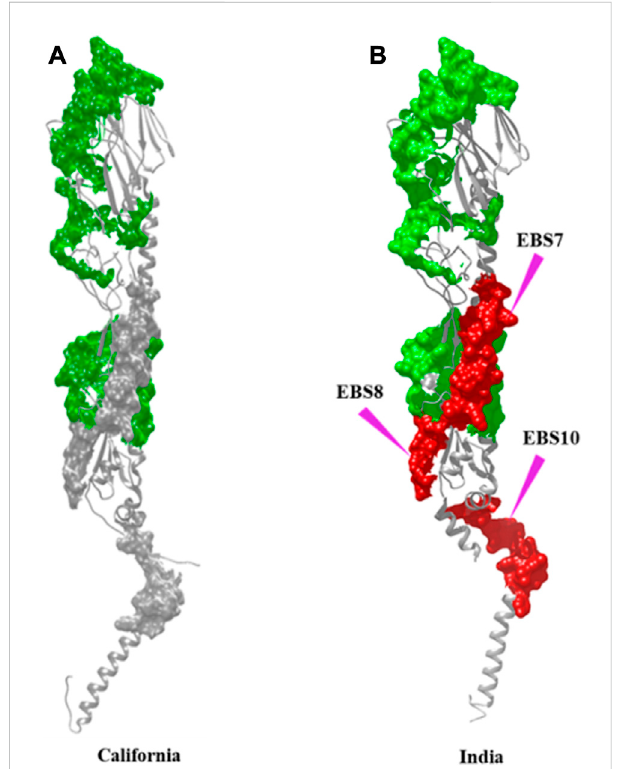
FIGURE 3 Antigenic sites, observed in common with both HA Cal (A) and HA Ind (B) strains, are shown in the green surface. Additional antigenic sites observed speci fi c to HA Ind proteins (2009 – 2018) are shown in the red surface. The sites of mutation are indicated by purple arrows.